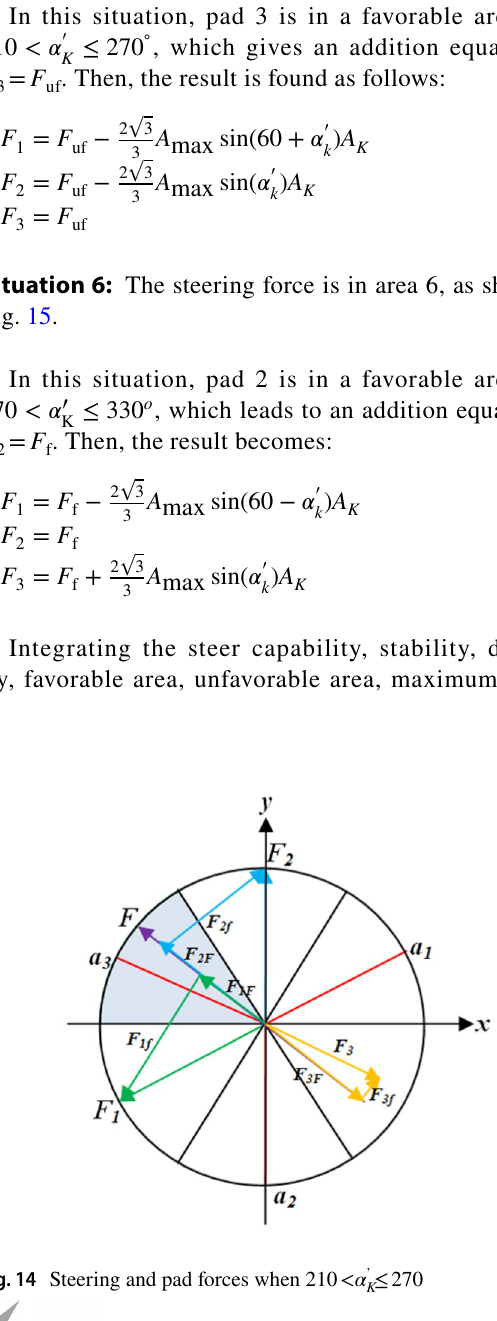
Fig. 14 Steering and pad forces when 210 < α